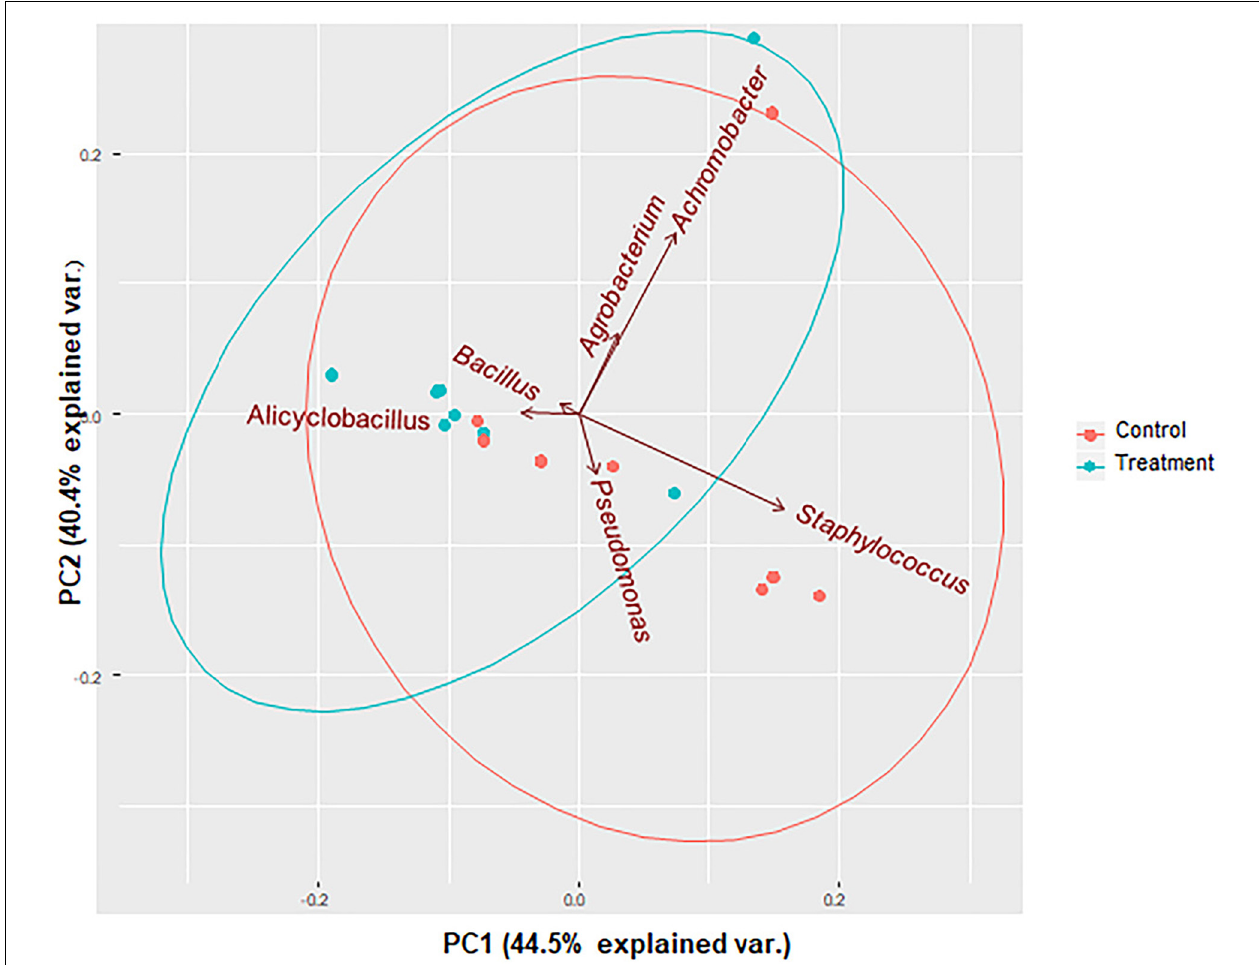
FIGURE 7 | PCA bi-plots of 16S rRNA-based relative abundance according to treatment group. Microbial community profile using beta diversity represented in biplot using weighted Unifrac distances for PCoA analysis. Colors correspond to the control group (red) in which animals were inoculated with only S. aureus RF122 and the treatment group (blue) in which animals were inoculated with both S. aureus RF122 and B. velezensis AP183. PCA indicates distinct differences between the two